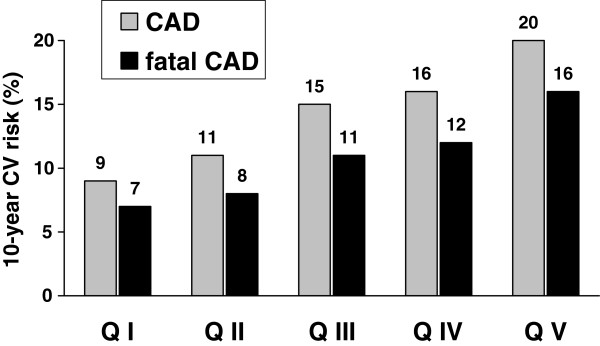
United Kingdom Prospective Diabetes Study Risk Engine’s 10-year absolute predicted risk of developing non-fatal or fatal coronary artery disease (CAD; grey bars) or fatal CAD (solid bars) in 258 T2DM females according to quintiles of log (TG)/HDL-C ranking distribution. Within each quintile, data were obtained from subsets of patients (in % for each quintile) in primary cardiovascular prevention (Q I: 81%; Q II: 81%; Q III: 69%; Q IV: 78%; and Q V: 71%). HDL-C: high-density lipoprotein cholesterol; TG: triglycerides. Significance of differences between quintiles: both P<0.0001 (CAD and fatal CAD).